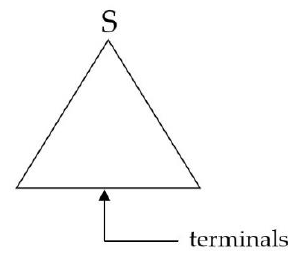
Figure 1. Initial